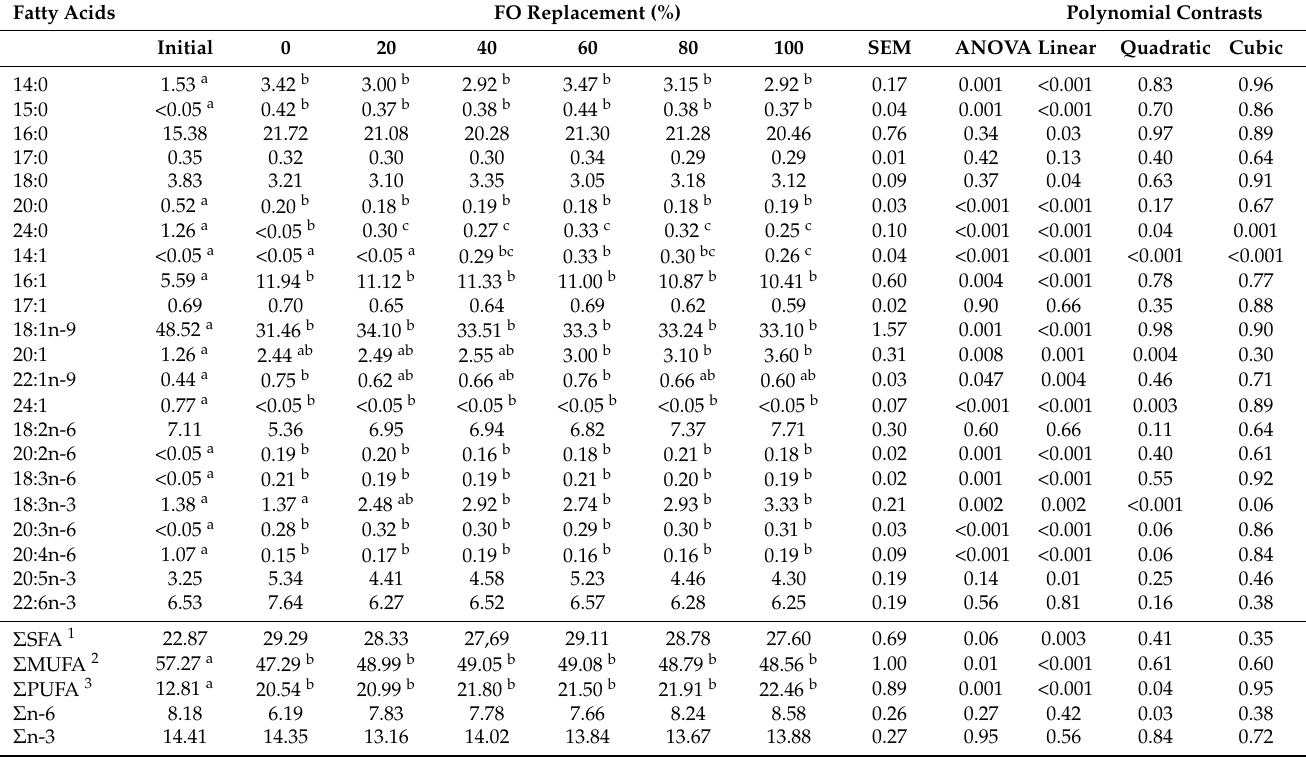
Table 7. Fatty acid profile (% of lipids) of the whole-body of juvenile tench fed experimental diets with different levels replacement of cod liver oil by a blend of vegetable